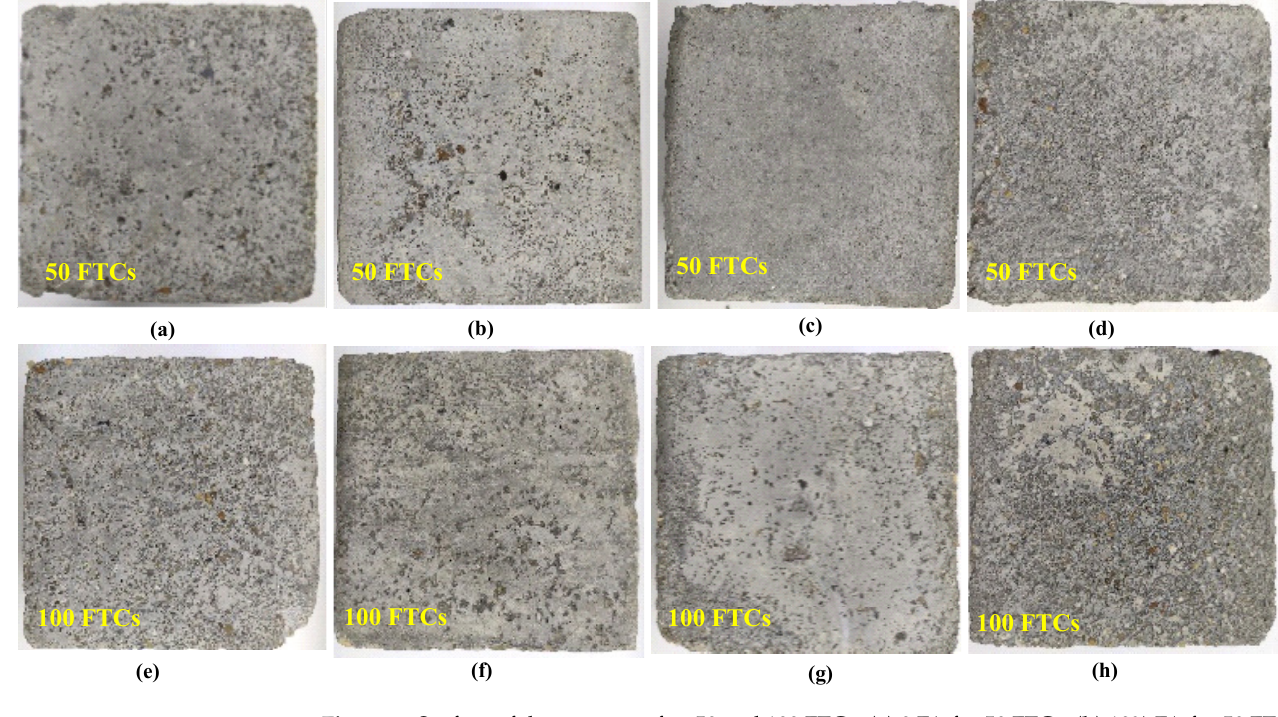
Figure 3. Surface of the concrete after 50 and 100 FTCs: ( a ) 0 FA for 50 FTCs, ( b ) 10% FA for 50 FTCs, ( c ) 20% FA for 50 FTCs, ( d ) 30% FA for 50 FTCs, ( e ) 0 FA for 100 FTCs, ( f ) 10% FA for 100 FTCs, ( g ) 20% FA for 100 FTCs, ( h ) 30% FA for 100 FTCs.